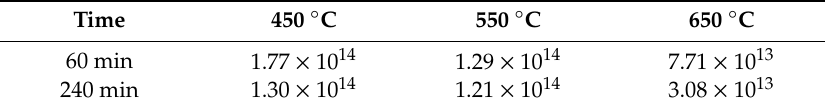
Table 3. Dislocation density of annealed Cu–Cr–In alloy (m − 2